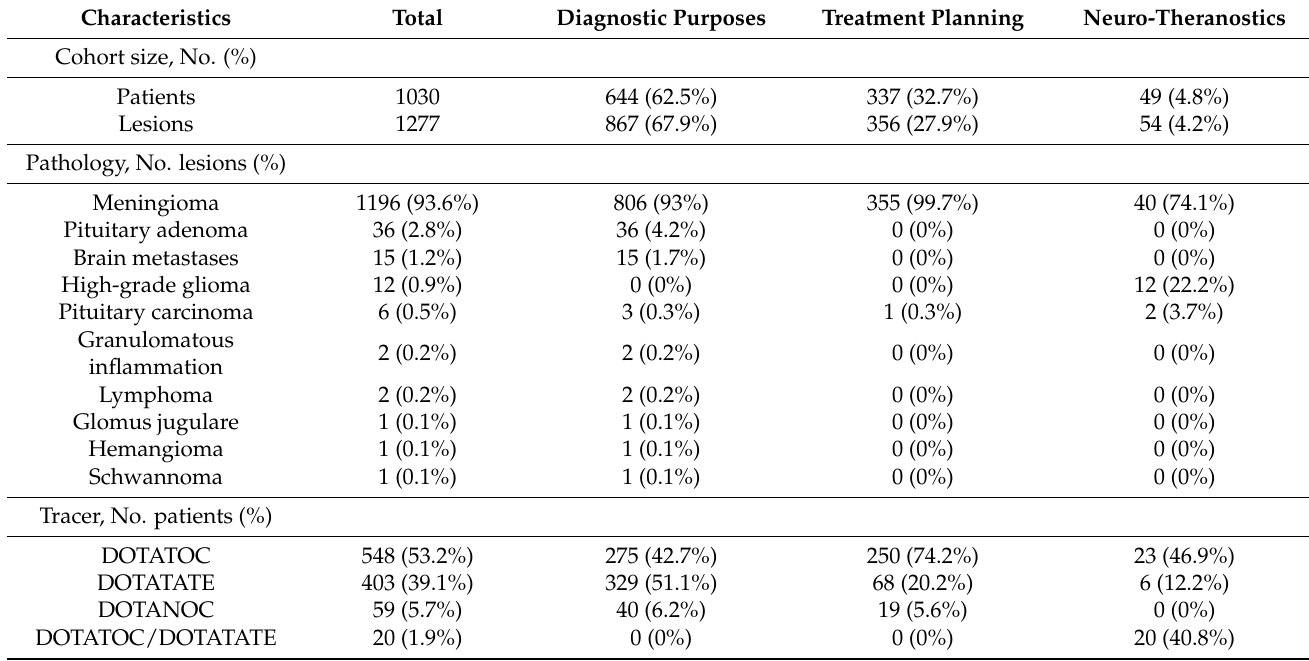
Table 1. Summary of all included studies and pooled